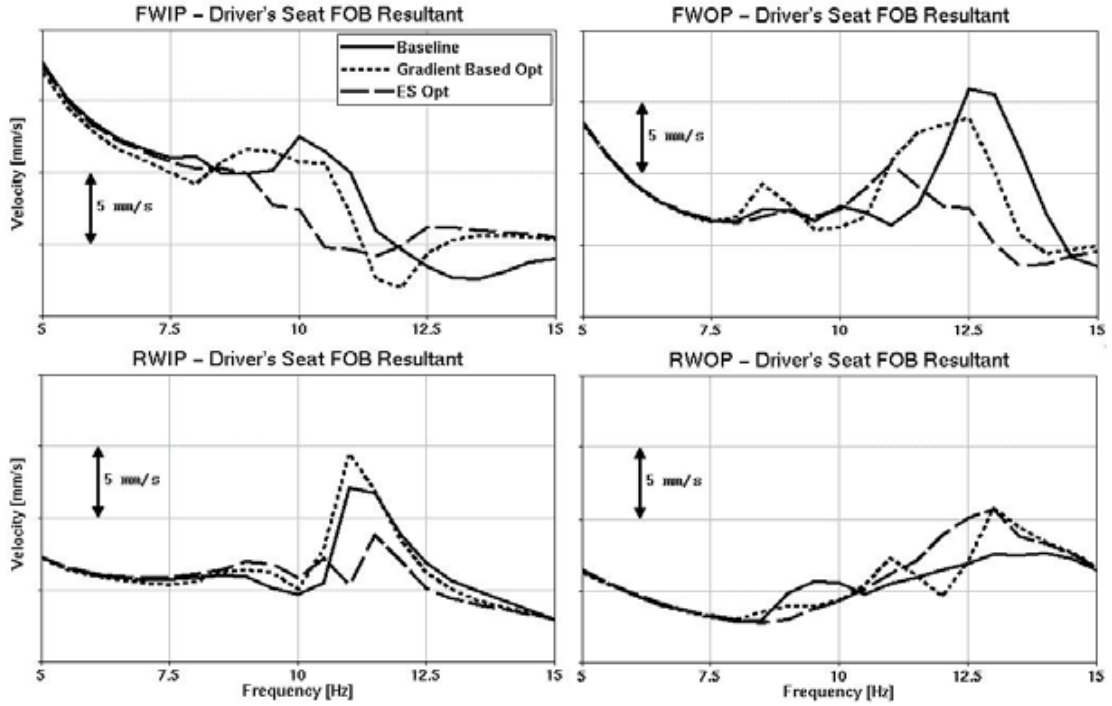
Fig. 14. Road shake response of the full-vehicle system at the driver’s seat front-out-board (FOB) bolt